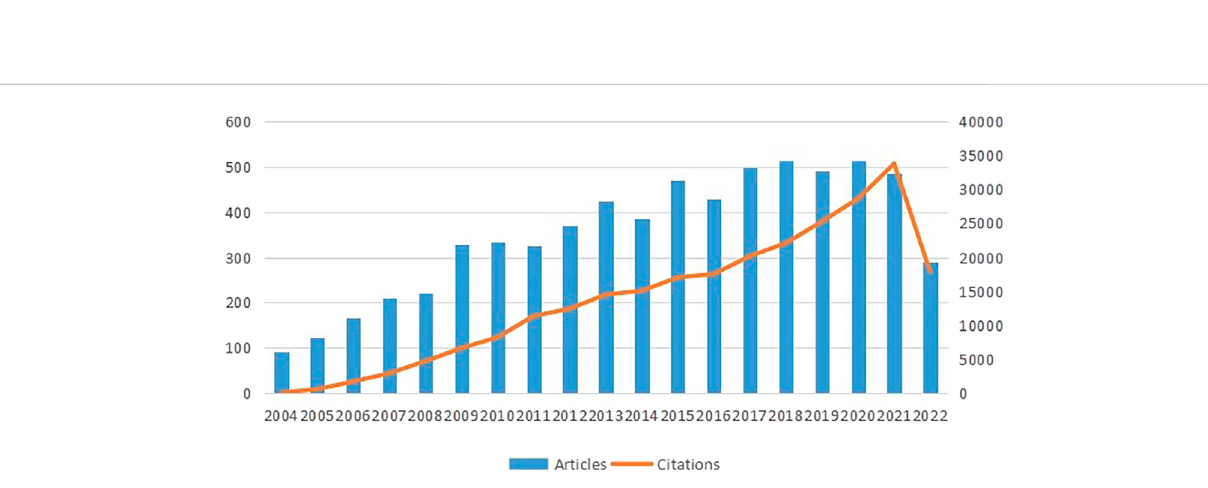
FIGURE 2 Trends of annual publications on research of stem cells in stroke. The data for 2022 is not